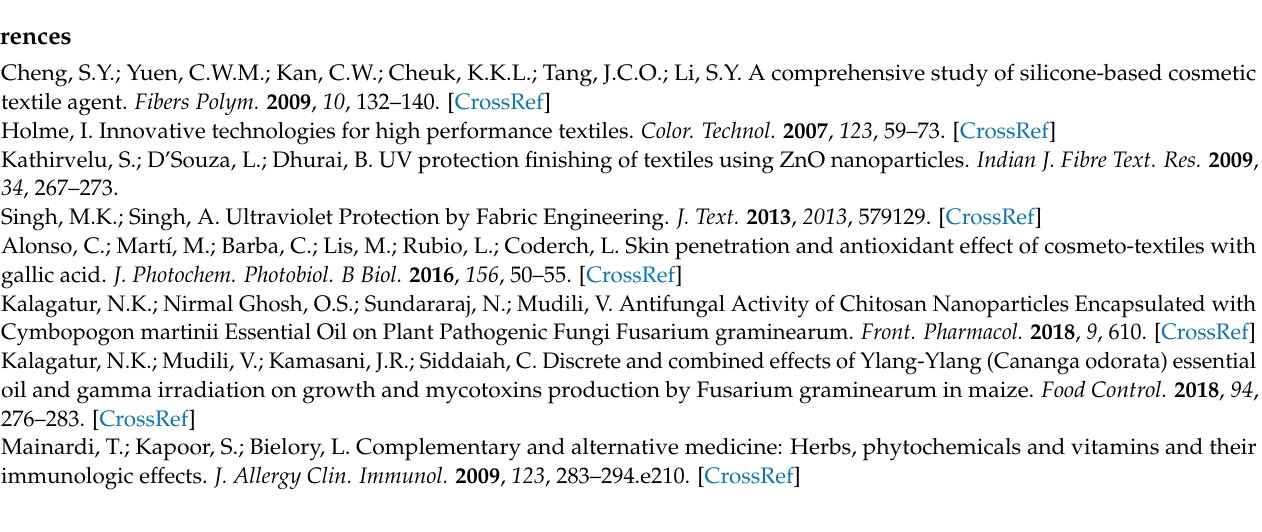
Figure S4: Comparison of pleasant olfactory character of the treated samples with different treatment methods. The results were obtained after the 3rd rub fastness test. Figure.S6: Comparison on the antibacterial activity between ultrasound, diffusion and padding treatment methods. After the 1st and 3rd rub fastness